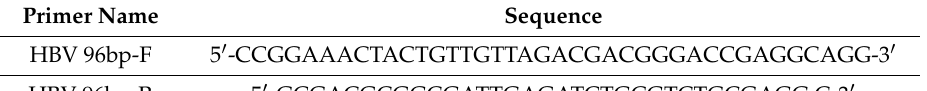
Table 1. Sequence of the Hepatitis B Virus (HBV) primer set for clcPCR.